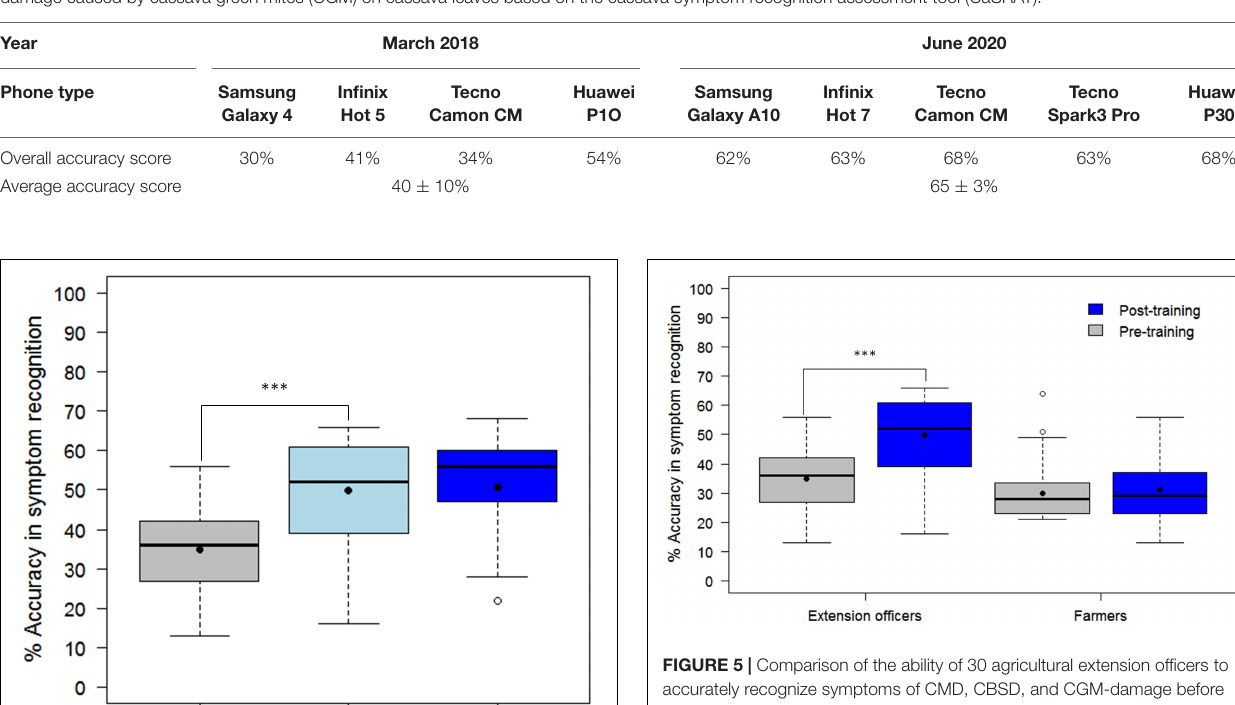
TABLE 4 | Comparison of overall accuracy of Nuru for identification of foliar symptoms of cassava mosaic disease (CMD), cassava brown streak disease (CBSD), and damage caused by cassava green mites (CGM) on cassava leaves based on the cassava symptom recognition assessment tool (CaSRAT).